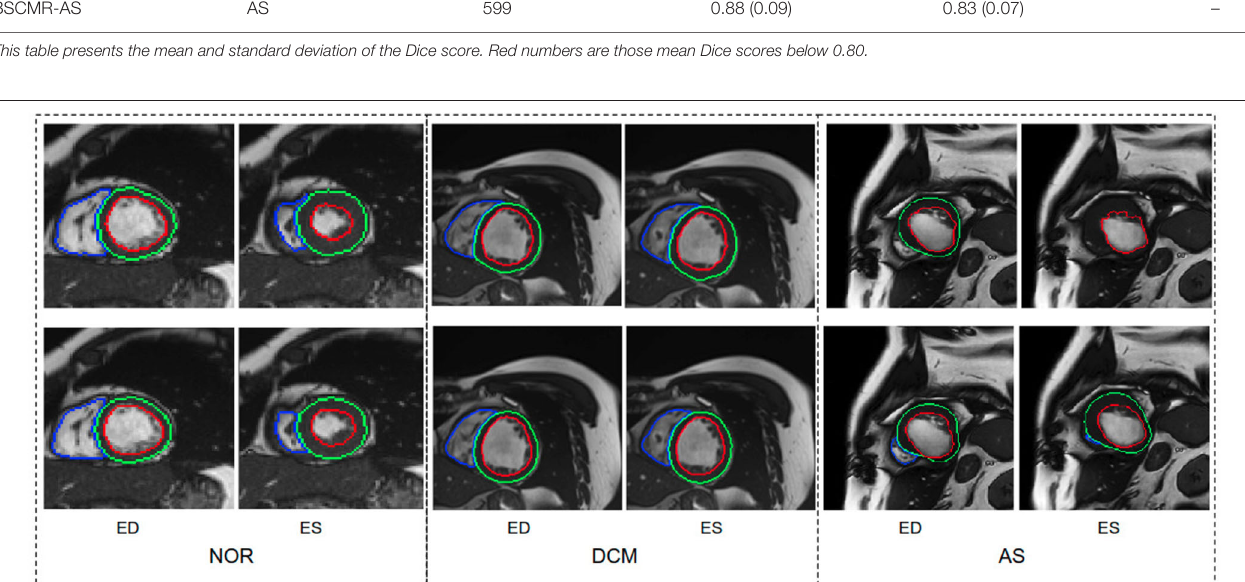
ARV pathology groups where lower Dice scores are